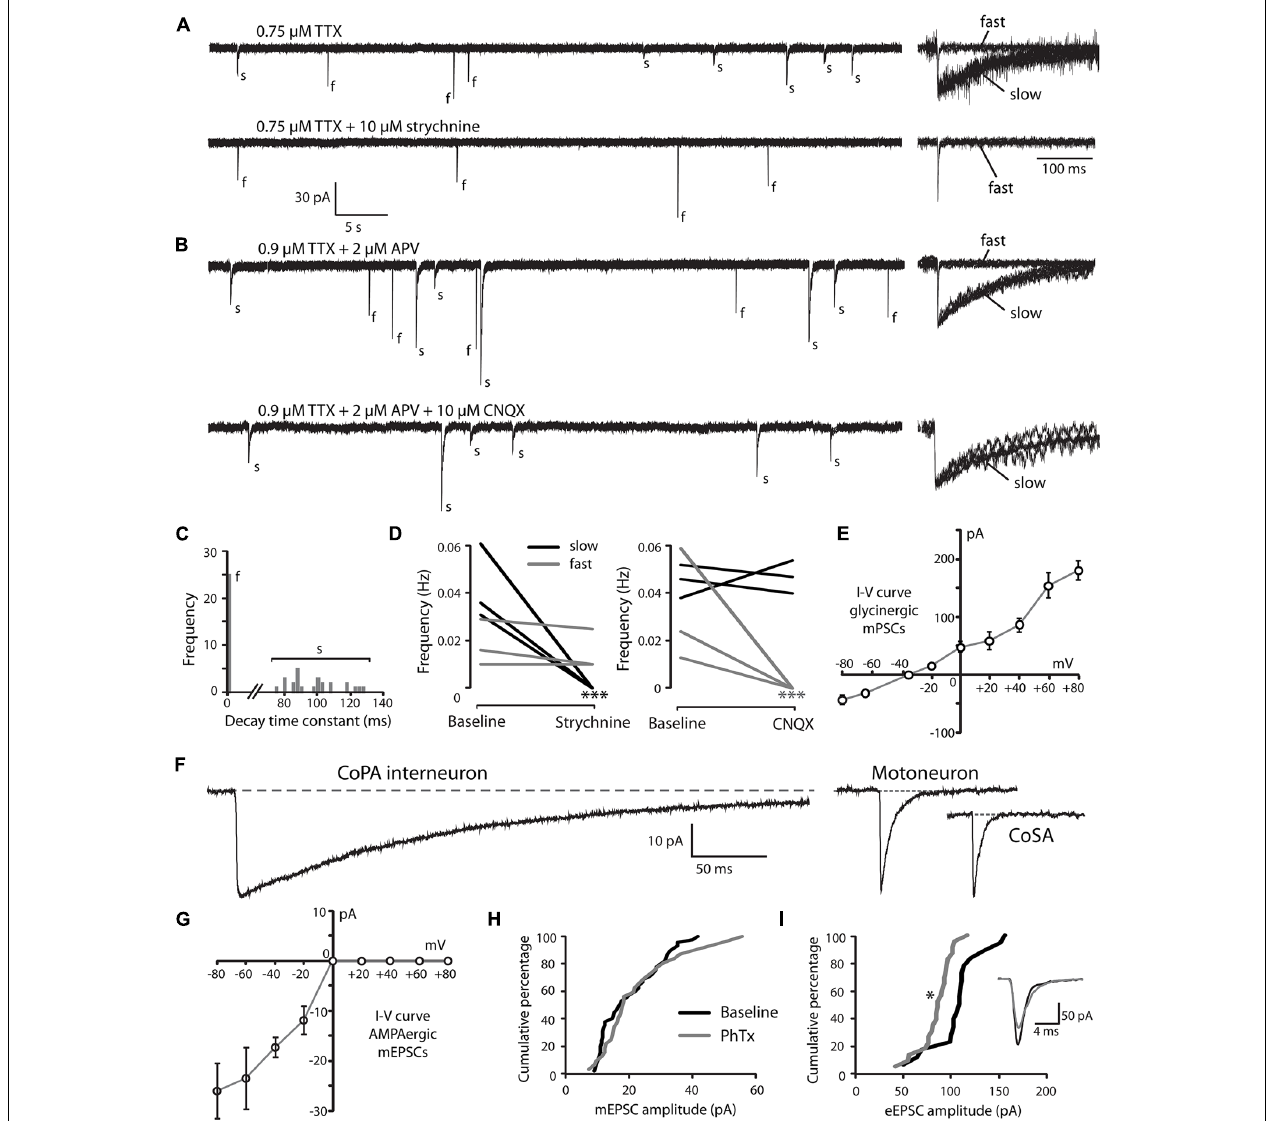
FIGURE 3 | Embryonic CoPAs have slow glycinergic miniature post-synaptic currents (mPSCs). (A) Representative excerpt of a whole-cell voltage-clamp recording from a CoPA interneuron in a 29 hpf embryo showing the presence of two distinct categories of mPSCs in the presence of 0.75 μ M tetrodotoxin (TTX) alone (upper trace, left) labeled “s” and “f” to denote slow and fast events, respectively. Following the additional wash-in of 10 μ M strychnine (lower trace, left), slow events are lost but fast events remain, indicating that slow events are glycinergic. Insets at the right show the vertically scaled overlay of all events from the recording excerpt at the left on an expanded timescale. (B) Representative excerpt of a whole-cell voltage-clamp recording of mPSCs from a CoPA interneuron in a 28 hpf embryo in the presence of 0.9 μ M TTX and 2 μ M (2R)-amino-5-phosphonovaleric acid (APV; upper trace) with events labeled as in (A) . Following the additional wash-in of 10 μ M CNQX (lower trace), fast events are lost but slow events remain, indicating that fast events are glutamatergic. Scale for traces and inset same as for (A) . (C) Frequency histogram of the first 50 events from the recording in TTX only in (A) showing a clear bimodal distribution of the decay time constants for mPSCs. (D) Left, line graph showing that the frequency of slow glycinergic mPSCs (black lines) is abolished with 10 μ M strychnine ( ∗∗∗ p < 0.001; for comparison of mini frequency from each